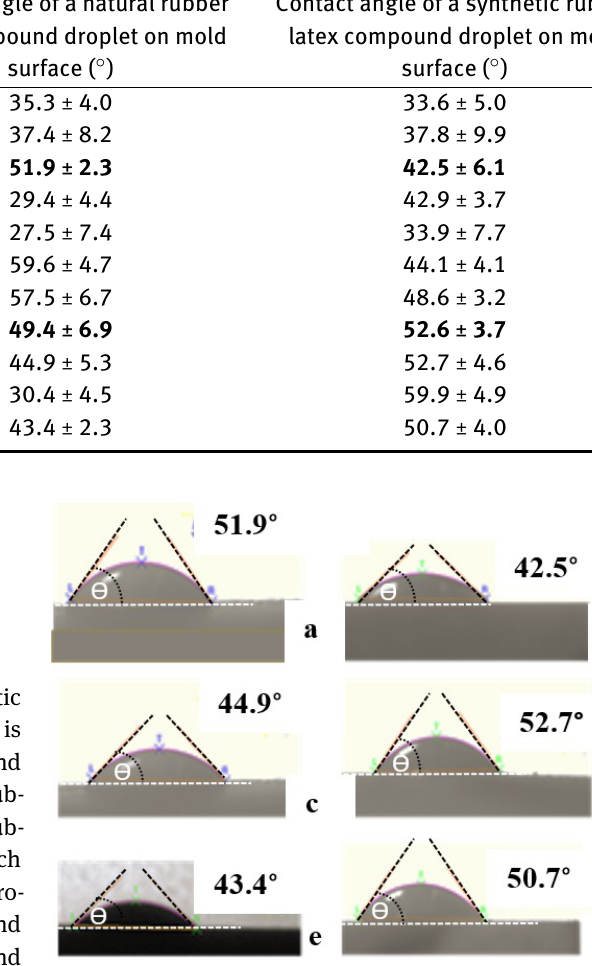
Figure 8: Contact angles of latex droplets on ceramic hand mold surfaces coated with CaCl 2 from eggshell: a) natural rubber latex droplet on porcelain mold fired at 1270 ∘ C; b) synthetic rubber latex droplet on porcelain mold fired at 1270 ∘ C; c) natural rubber latex droplet on bone china mold fired at 1270 ∘ C; d) synthetic rubber latex droplet on bone china mold fired at 1270 ∘ C; e) natural rubber latex droplet on commercial ceramic hand mold; f) synthetic